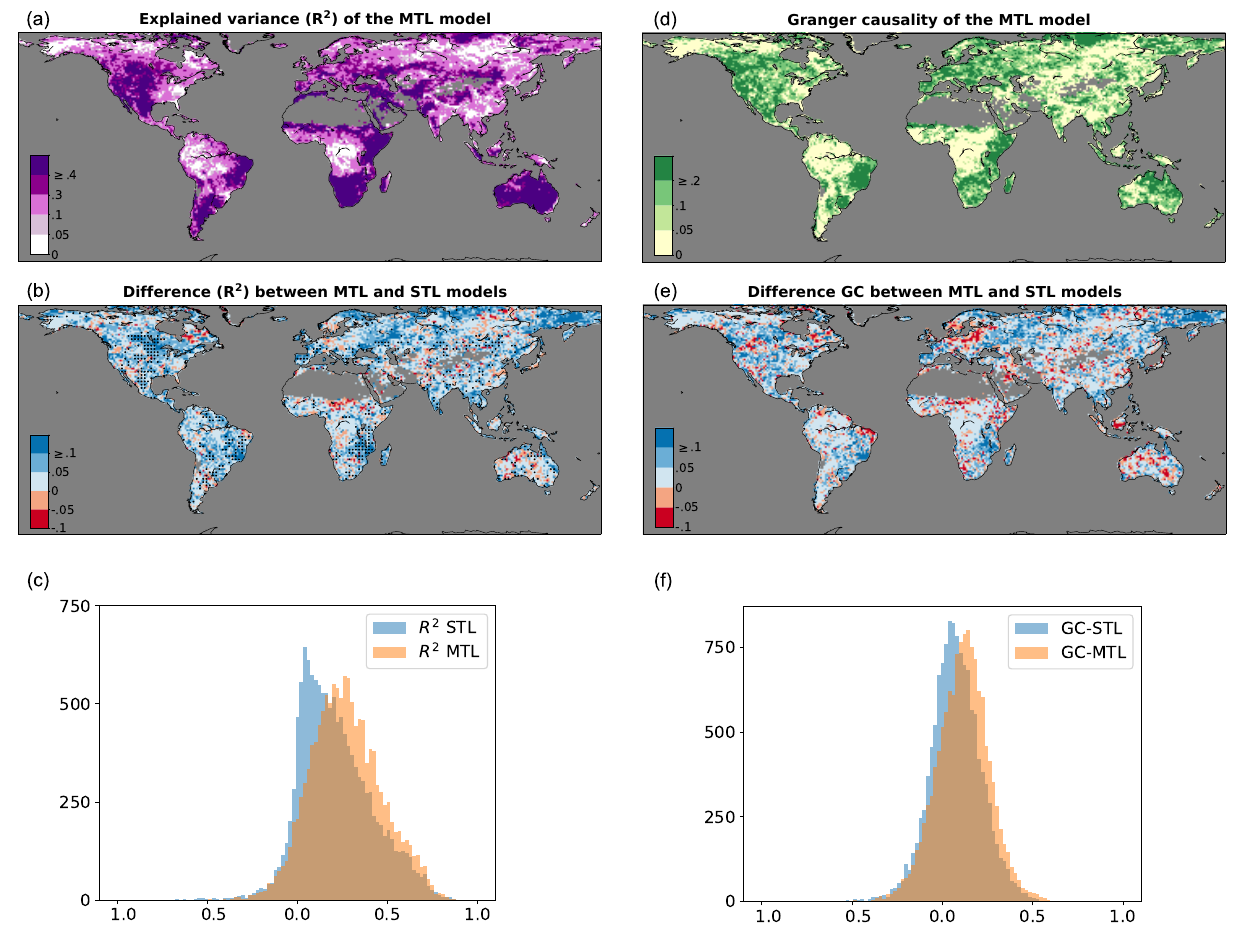
Figure 3. Comparison of the predictive performance between the STL and the MTL approaches. (a) Explained variance ( R 2 ) of the NDVI monthly anomalies based on the MTL approach. (b) Difference in terms of R 2 between the MTL and the STL approaches; blue regions indicate a higher performance by the MTL. The dotted regions correspond to areas where the MTL model significantly outperforms the STL models based on the Diebold–Mariano statistical test (Diebold, 2015). (c) Comparison of the distributions of the R 2 scores in the STL and in the MTL setting; the blue histogram corresponds to the STL, and the orange one to the MTL approach. (d) Quantification of Granger causality for the MTL approach, i.e. improvement in terms of R 2 by the full MTL model with respect to the R 2 of the baseline MTL model that uses only past values of NDVI anomalies as predictors; positive values indicate Granger causality (Papagiannopoulou et al., 2017a). (e) Difference in terms of Granger causality between the MTL and the STL approaches; blue regions indicate a higher performance by the MTL. (f) Comparison of the distributions of Granger causality in the STL and in the MTL setting; the blue histogram corresponds to the STL, and the orange one to the MTL